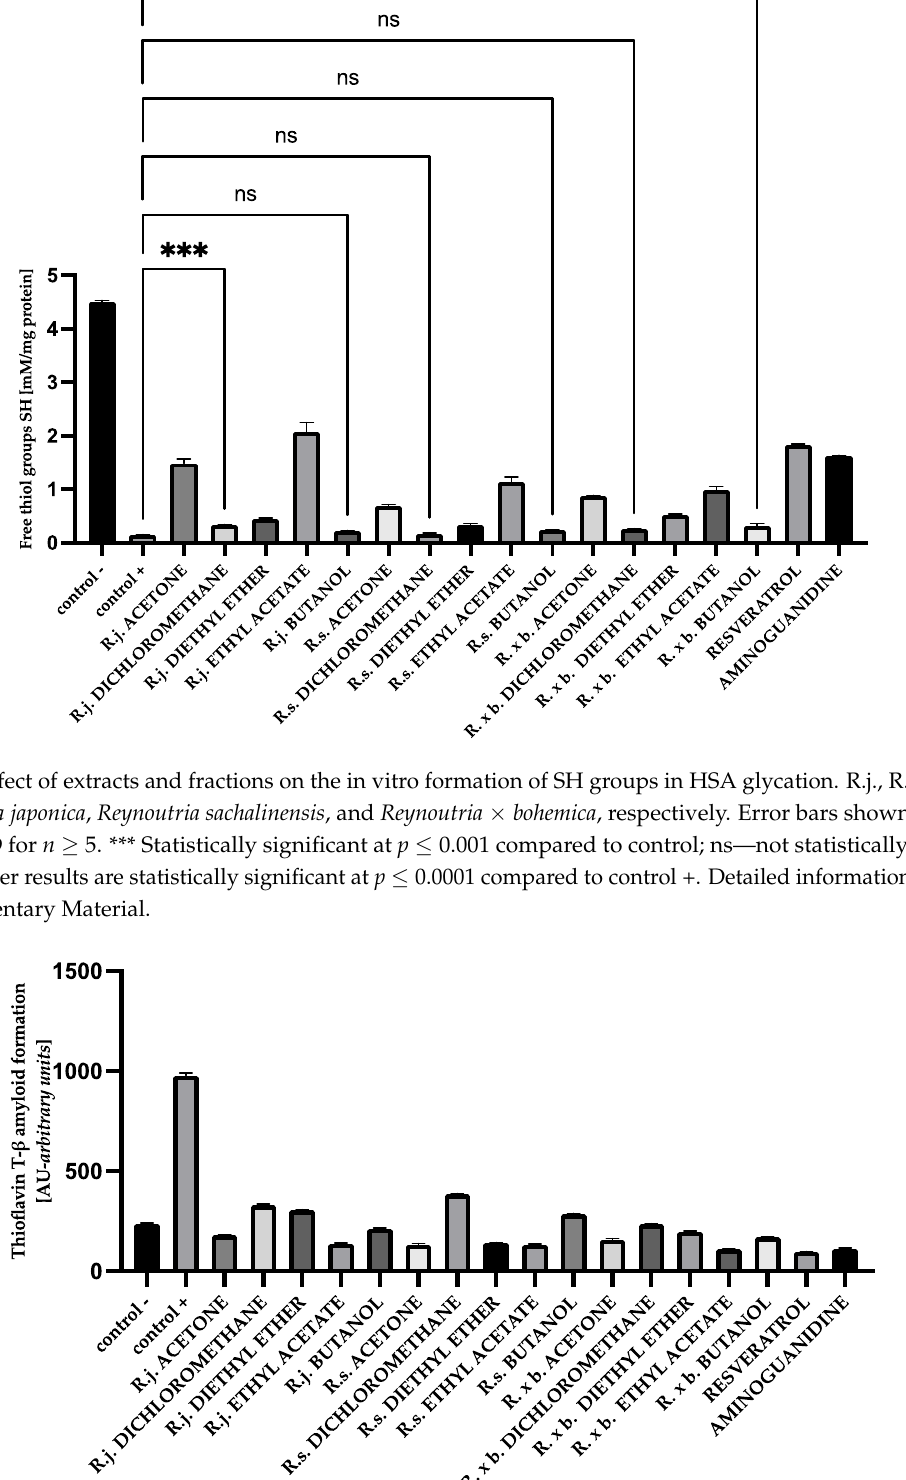
Figure 11. The effect of extracts and fractions on the in vitro formation of amyloid- β products—thioflavin T in HSA gly- cation. R.j., R.s., and R. × b. mean Reynoutria japonica , Reynoutria sachalinensis , and Reynoutria × bohemica , respectively. Error